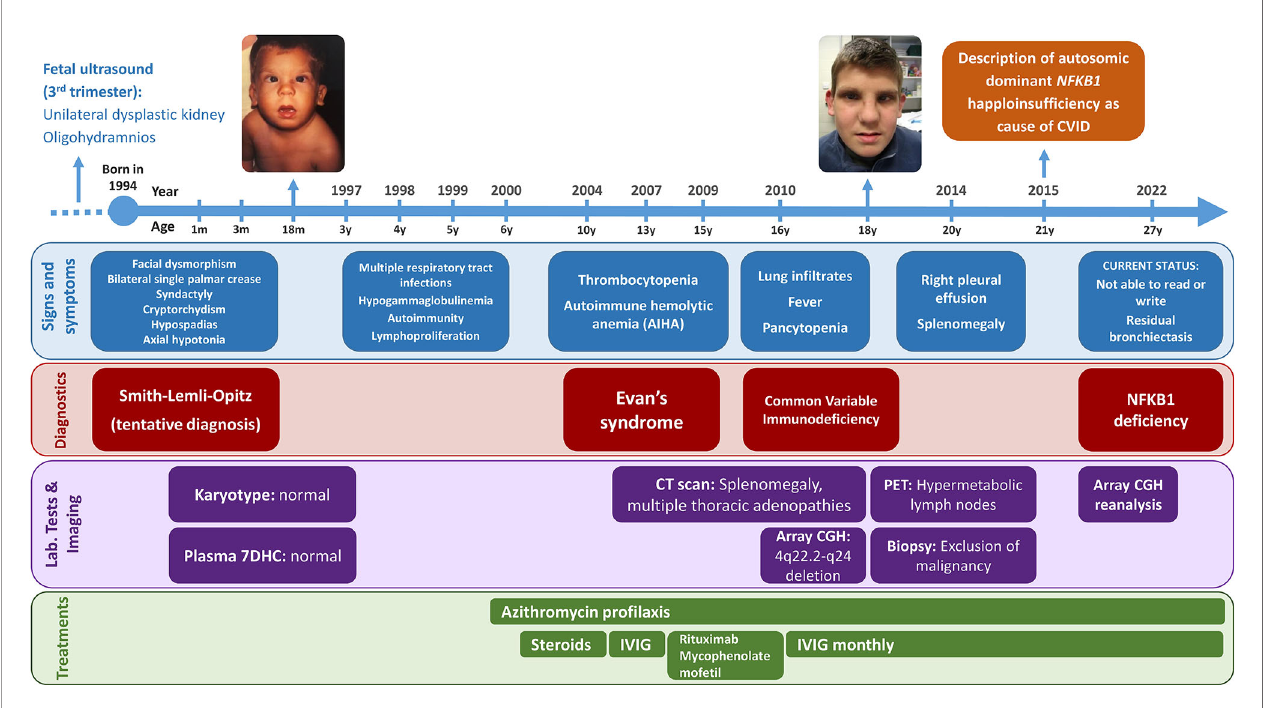
FIGURE 1 | Timeline of the patient ’ s clinical history. Items are classi fi ed into signs and symptoms (blue), diagnoses (red), laboratory tests and imaging (purple), and treatments (green). The patient ’ s images are included with the explicit consent of the patient and his